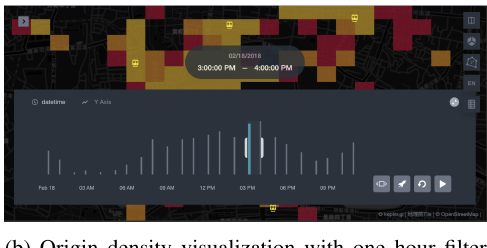
Figure 4. Visualization of Get-on and Get-off numbers for the event of 27 th May, 2018 at Tokyo Race Course venue.